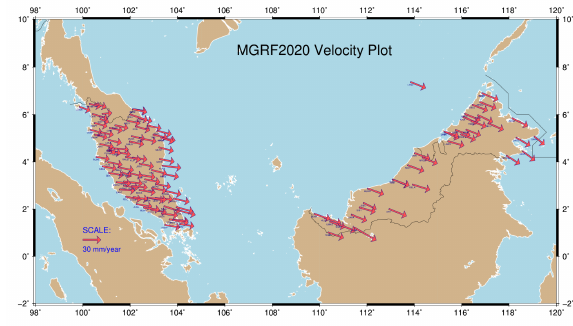
Fig. 7. Horizontal velocities of the Malaysian network